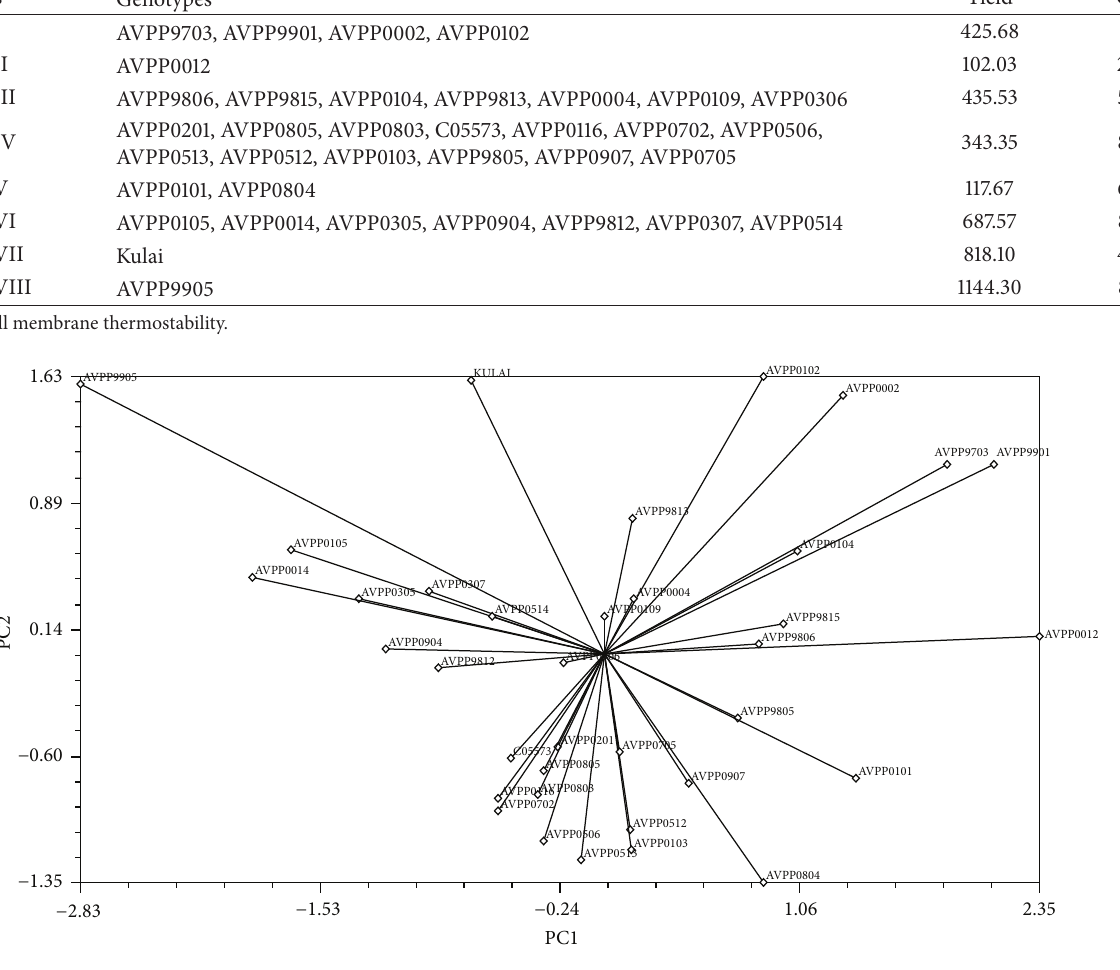
Figure 4: Two-dimensional graph principal component analysis showing relationship among the genotypes for cell membrane thermosta- bility and